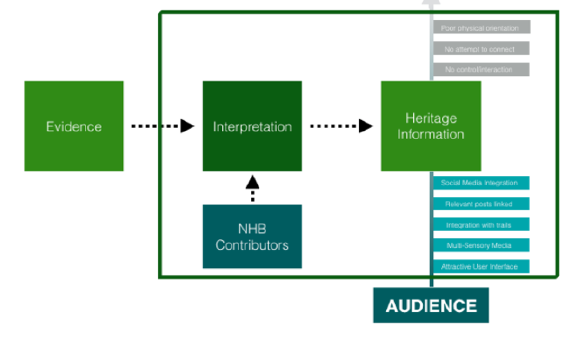
Figure 9. Roots Information Flow Analysis